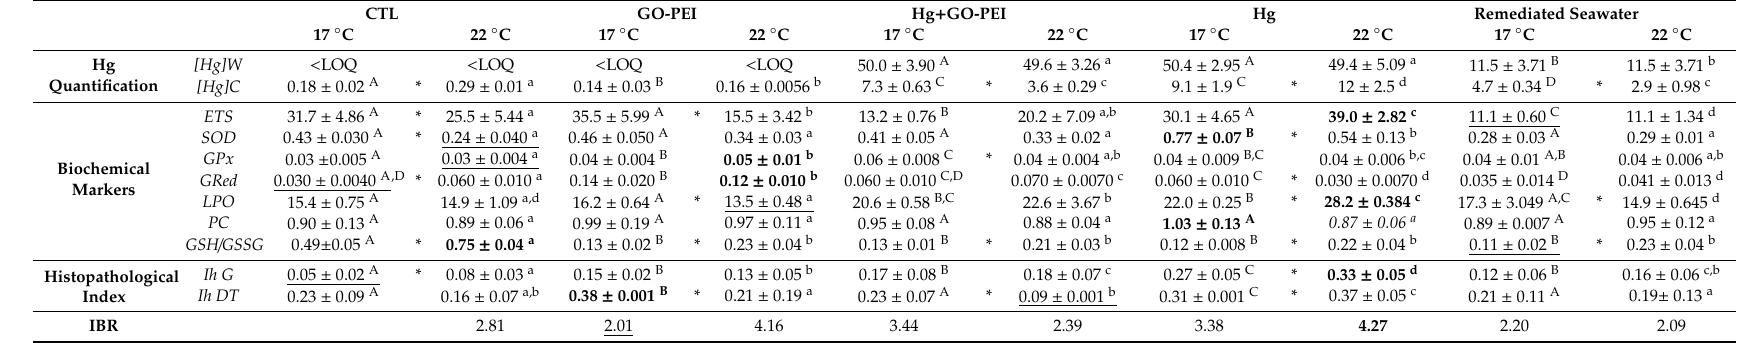
Table 2. (i) Hg quantification: water samples ([Hg] W) µ g / L collected immediately after the weekly water renewal for each treatment; clams ([Hg] C) mg / Kg collected at the end of the experiment. Levels not detectable (below the limit of quantification, < LOQ). (ii) Biochemical markers in Ruditapes philippinarum collected 28 days after the beginning of the experiment: electron transport system (ETS) activity nmol / min / g fresh weight (FW); superoxide dismutase activity (SOD) U / g FW; glutathione peroxidase (GPx) activity U / g FW; glutathione reductase (GRed) activity U / g FW; lipid peroxidation levels (LPO) nmol MDA / g FW; protein carbonyl levels (PC) nmol / g FW; ratio between reduced and oxidized glutathione (GSH / GSSG). (iii) Histopathological markers collected 28 days after the beginning of the experiment: Gills ( Ih G) ih ; digestive tubules ( Ih DT) ih . Results are mean + standard deviation. Statistical di ff erences among the treatments at 17 and 22 ◦ C (The meaning of the letters is in the legend. Uppercase letter are used to identify statistical di ff erences among treatments at 17 ◦ C. While lowercase letter are used to identify statistical di ff erences among treatments at 22 ◦ C were presented with di ff erent uppercase letters and lowercase letters, respectively. Significant di ff erences between treatments 17 ◦ C vs. 22 ◦ C (*) are presented with asterisks. The highest values for each biomarker were highlighted in bold, while the lowest values were